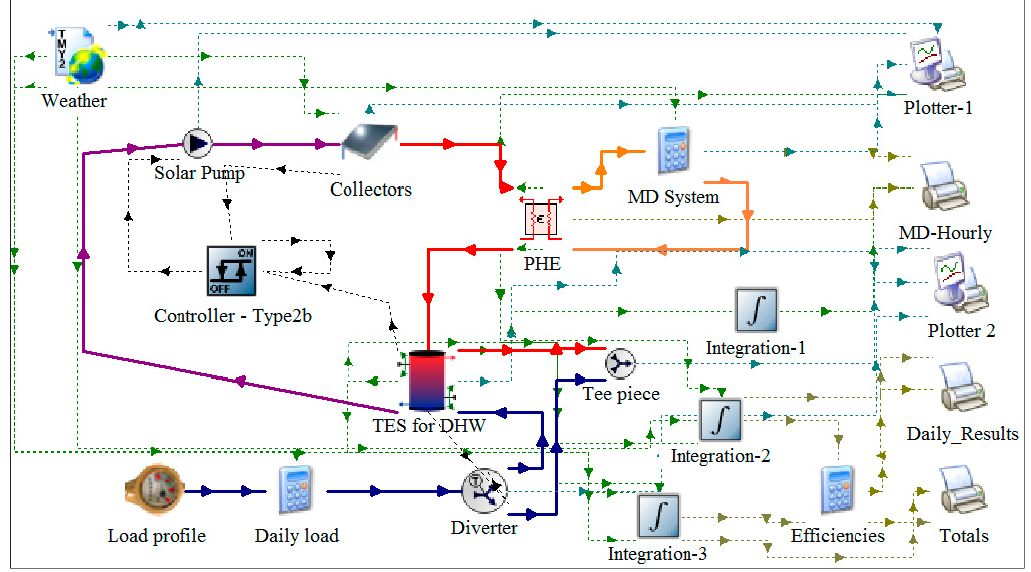
Figure 6. System assembly diagram of SCMD system in TRNSYS simulation studio.